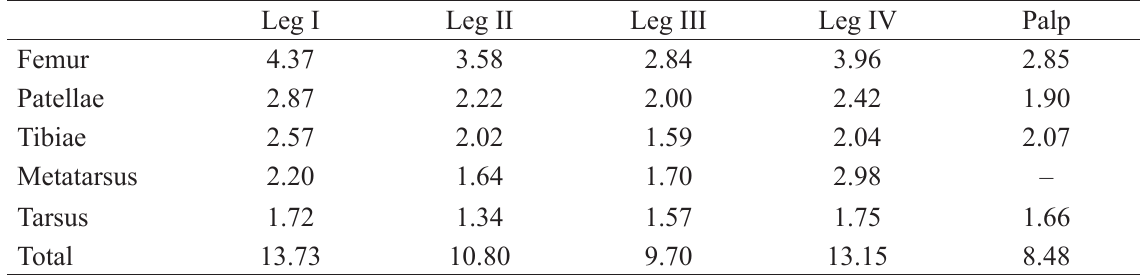
Table 4. Bistriopelma kiwicha sp. nov., paratype, ♀ (MUBI 41); length of palpal and leg